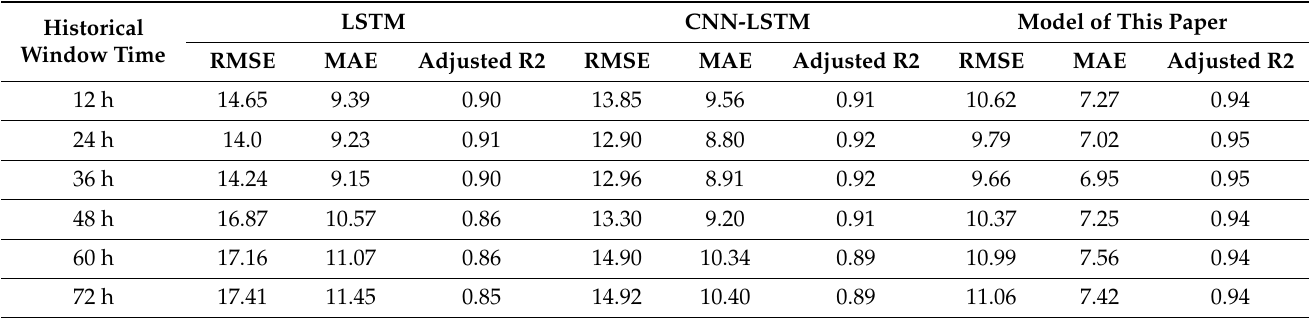
Table 2. Performance comparison of models in different historical time windows.